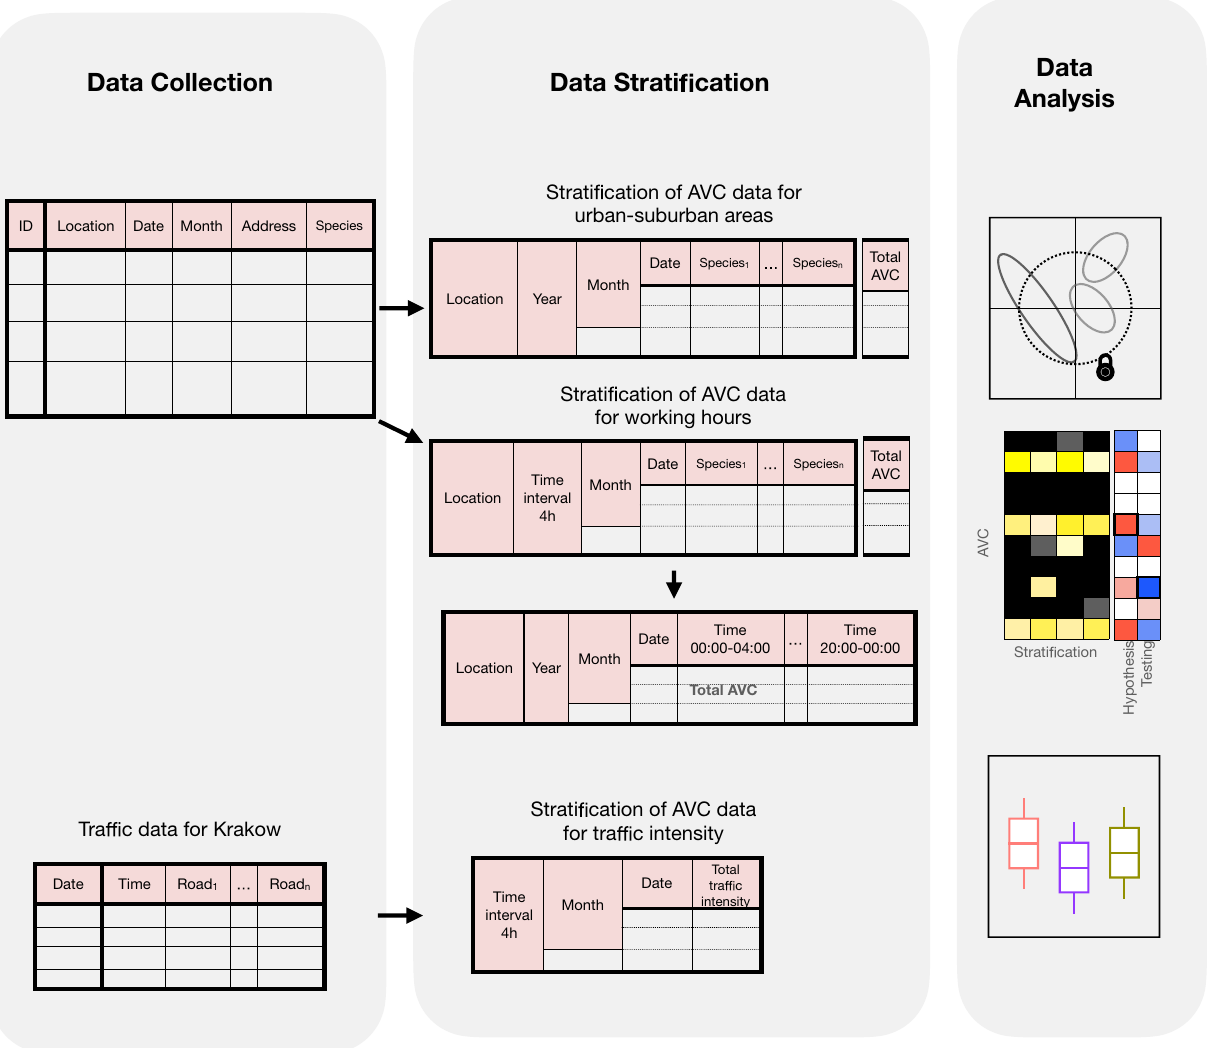
Figure 7. Workflow and data stratification. General workflow for analysing the two research